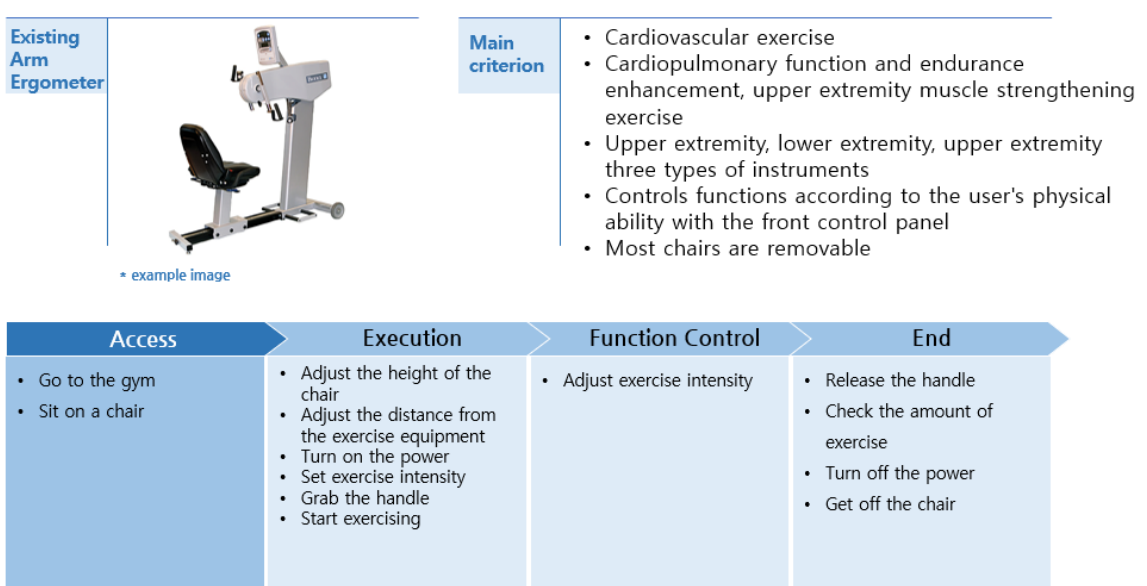
Figure 4. Arm ergometer concept idea . Table 8. Problems of existing arm ergometer and concept ideas applying universal design.